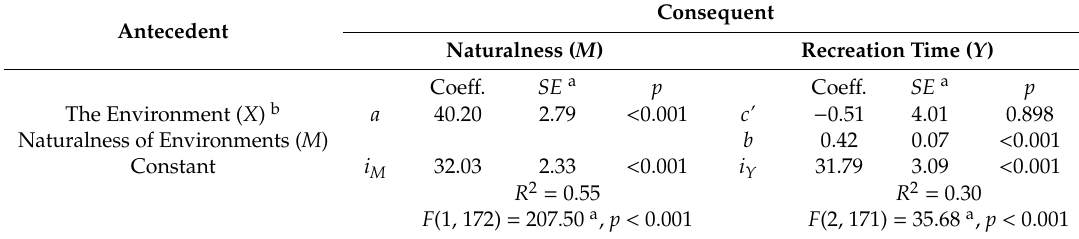
Table 3. Model coe ffi cients for the simple mediation for environments with inanimate soundscapes. Consequent Antecedent Naturalness ( M ) Recreation Time ( Y ) Coe ff . SE a p Coe ff . SE a